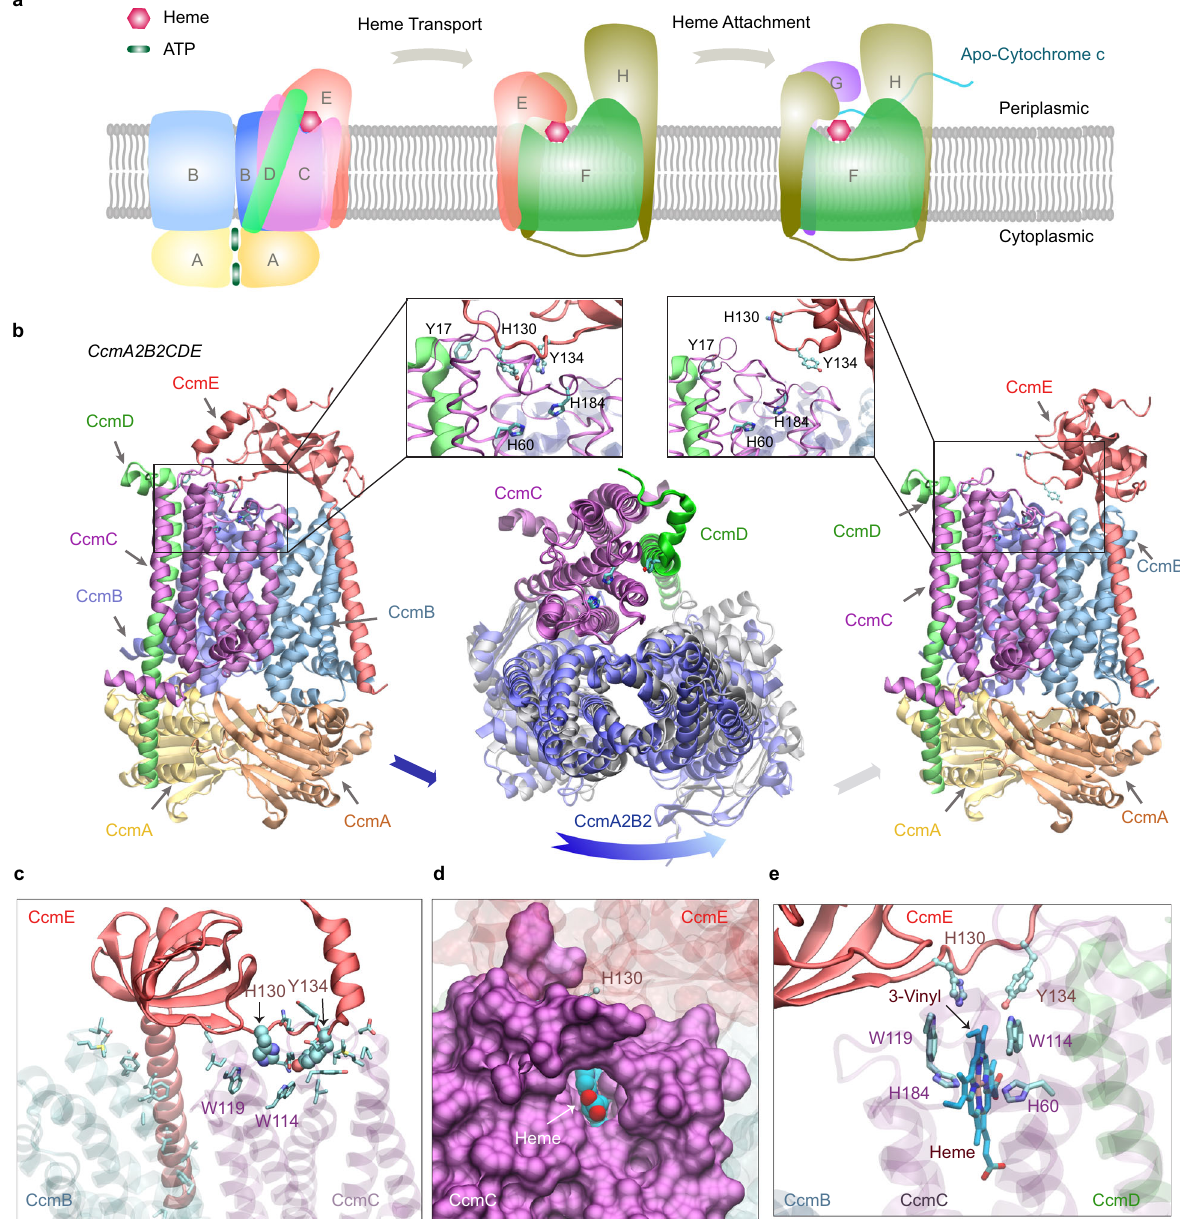
Fig. 6 E. coli cytochrome c maturation system I. a An illustration of the Ccm I system, composed of eight proteins named CcmABCDEFGH. The system covalently attaches heme molecules to cytochrome c proteins via three functional complexes. b Two models (left and right panels) of one complex: CcmA 2 B 2 CD engage CcmE (left panel) and disengage CcmE (right panel). which loads a heme from CcmA 2 B 2 CD and chaperones it to CcmF. Insets show conserved residues implicated for heme binding in CcmC, CcmD, and CcmE, respectively. Conformational differences between these two models are shown in the middle panel, where the backbone of CcmC was used to superimpose the two models. Viewed from the periplasmic side, the two conformations of CcmA 2 B 2 are displayed in blue and grey. Movement relative to CcmC is evident in CcmA 2 B 2 but not in CcmD. For clarity, CcmE is omitted in this superposition plot. c A view of interactions between CcmCD and CcmE in their engaged structural model shown in the left panel of ( a ). CcmCD representations are transparent for clarity. The side chains of interacting residues are shown. His130 and Tyr134 of CcmE are shown in the van der Waals representation, and other interacting residues, including Trp114 and Trp119 from the heme-binding WWD domain of CcmC, are shown in the licorice representation. ( d , e ) Views of a heme molecule bound in the putative binding-pocket in CcmC, using the structural model in which CcmE is bound to CcmA 2 B 2 CD as the initial apo structure. A pore for heme access in CcmC manifests, where CcmC is rendered in a surface representation ( d ). The heme is displayed in van der Waals ( d ) and licorice ( e ) representations. The vinyl group expected for His130 CcmE attachment is marked in ( e